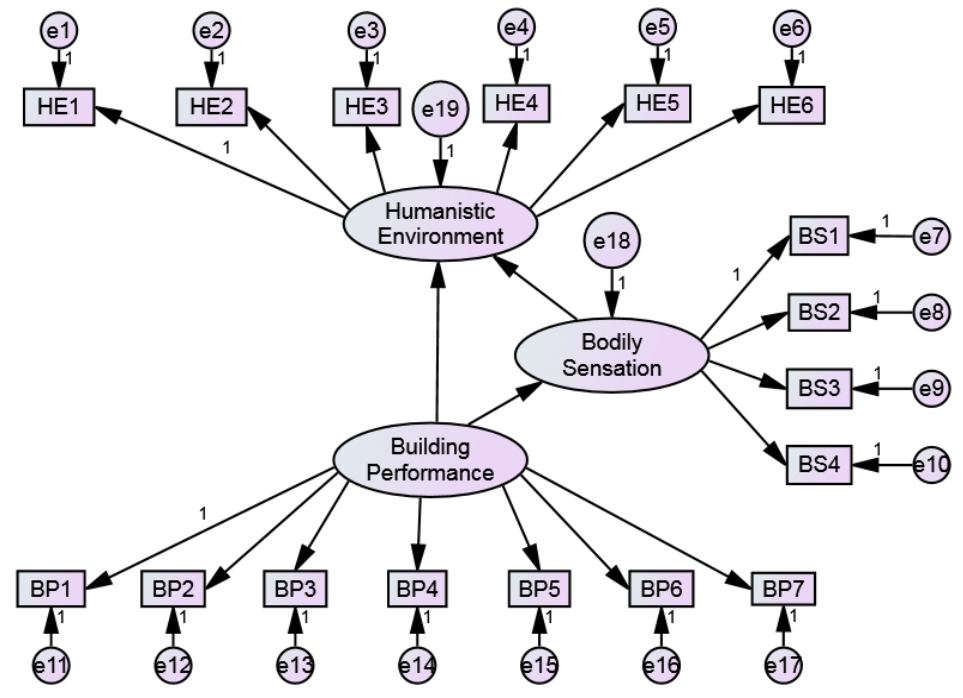
Figure 5. Initial Figure 5. Initial model.